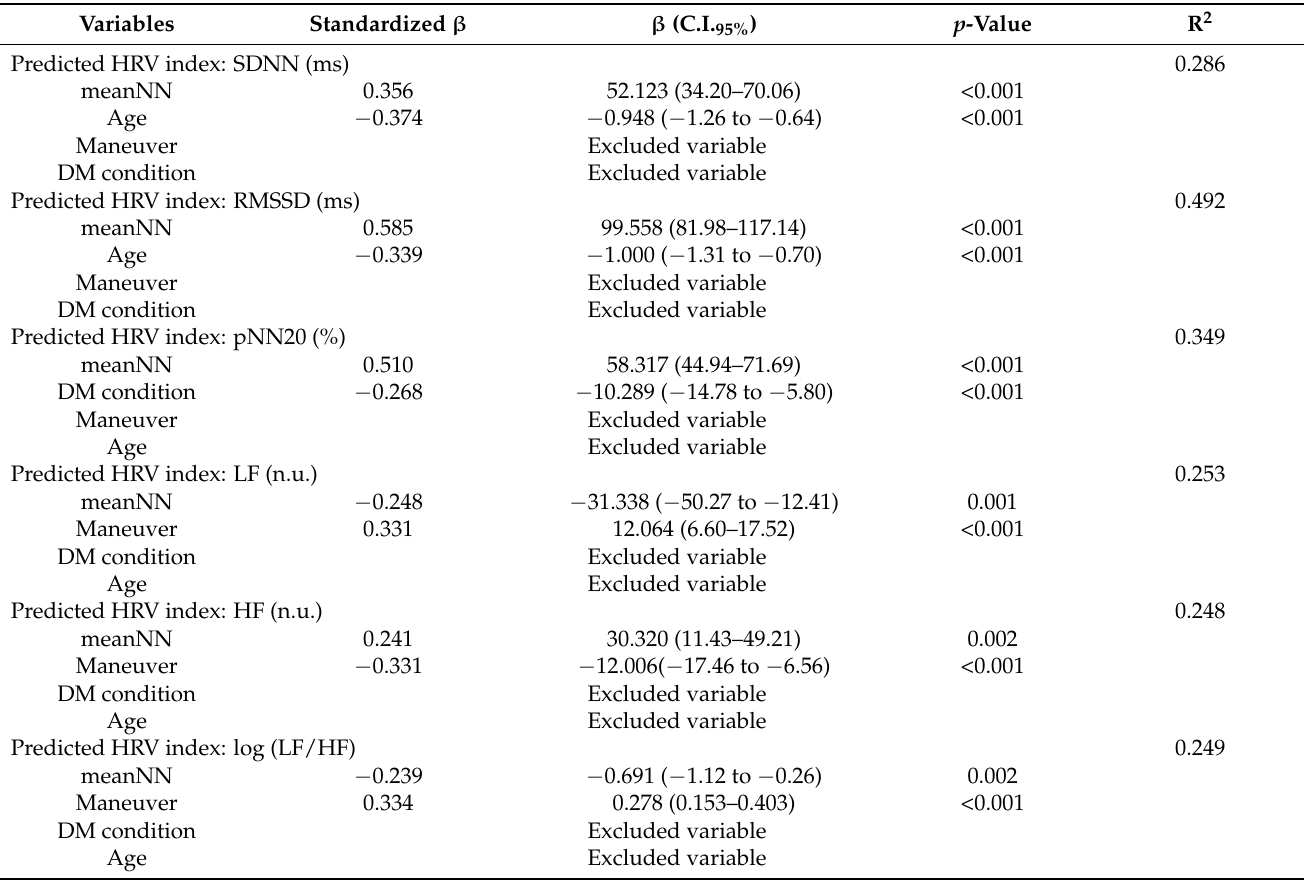
Table 4. Linear stepwise multiple regression analysis with predicted HRV indices and, as independent variables, the meanNN, maneuver, diabetes mellitus (DM) condition, and age. The regression models were applied on the combined samples from supine position and active standing in both groups (healthy and diabetes).